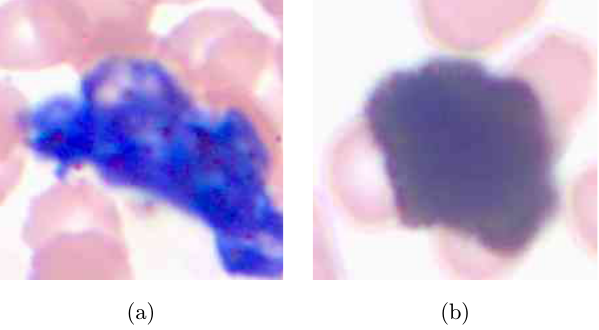
Fig. 16. NonWBC images (a) recognized as basophil and (b) recognized rightly.